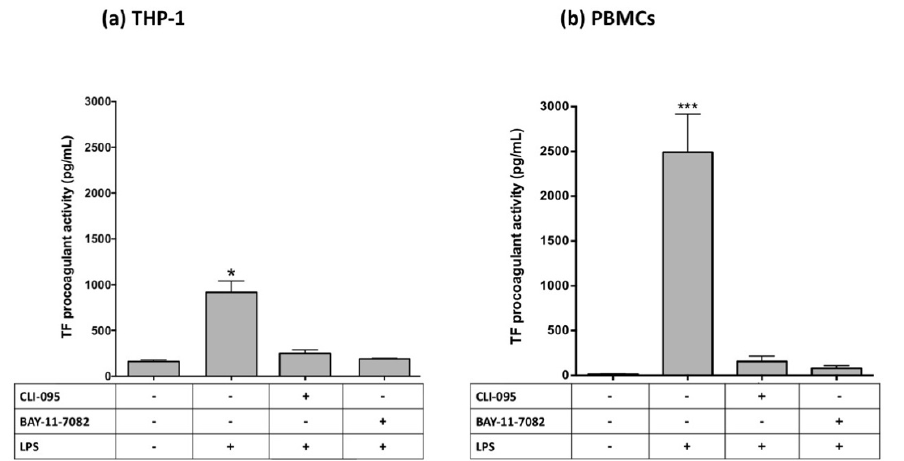
Figure 7. TF procoagulant activities measured in THP-1 ( a ) and PBMCs ( b ). Both cell lines were pre-treated with specific inhibitors (3 × 10 − 6 M CLI-095 and 10 − 5 M BAY-11-7082) for 30 min and subsequently stimulated with LPS (10 µ g/mL for 4 h for THP-1 and 0.1 µ g/mL for 18 h for PBMCs). Data are presented as mean ± SEM ( n = 8). * p < 0.05 vs. the basal condition; *** p < 0.001 vs. the basal condition.